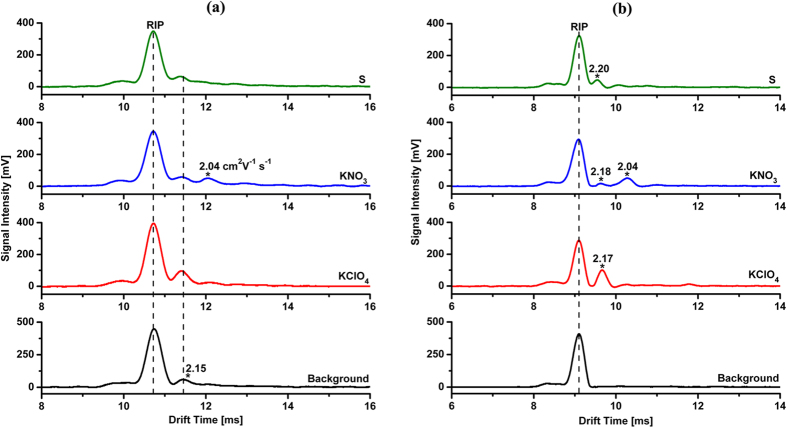
Ion mobility spectra of 600 ng KClO4, 4 ng KNO3 and 2 ng S using (a) large traditional Faraday detector (radius of 8.7 mm) and (b) Faraday detector with ion focusing in vicinity. To facilitate the evaporation of these compounds during the thermal desorption introduction, 15 μL of 3% H3PO4 solution was added into 1 mL of their test solutions.